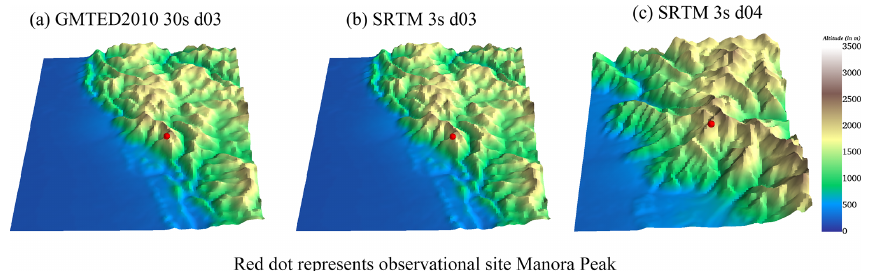
Figure 11. The topography from GMTED at 30s in domain d03 (a) , SRTM at 3s in domain d03 (b) , and SRTM at 3s in domain d04 (c) . The model elevations of the observational site in d03 and d04 are 1670 and 1876m,